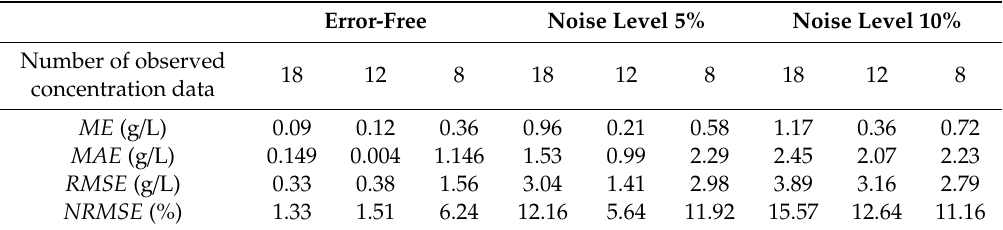
Table 6. Statistical parameters to test the accuracy in estimation of the source release